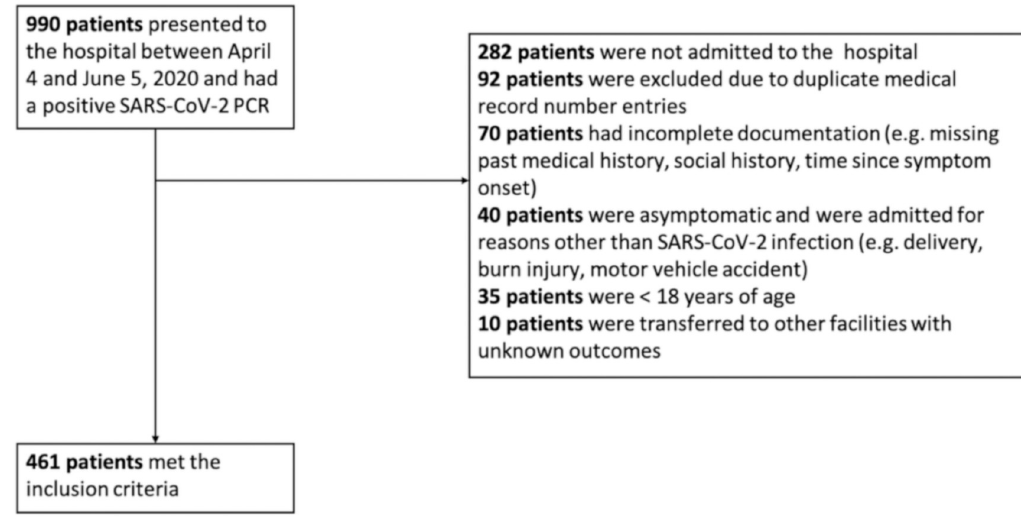
Fig 1. Study flow